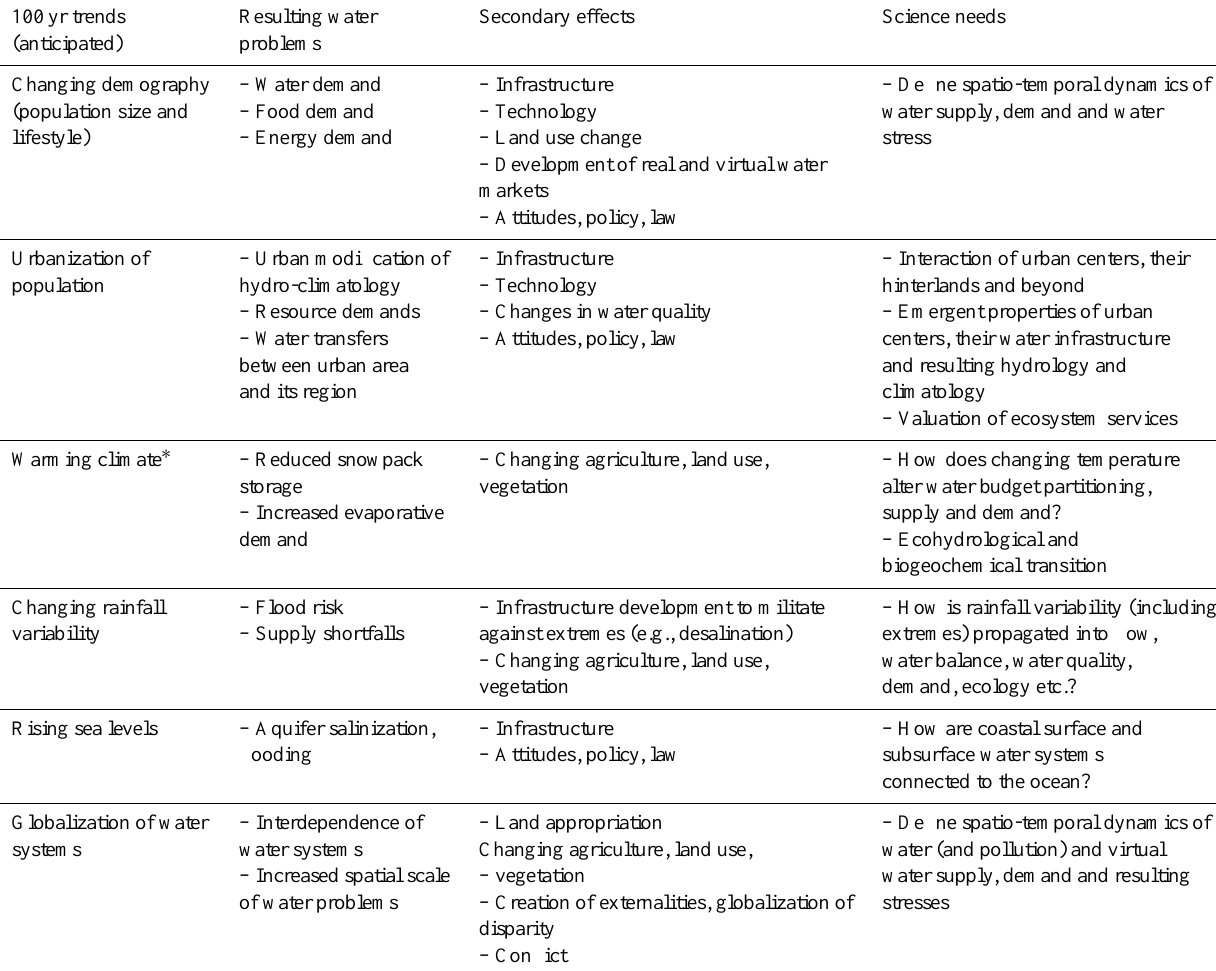
Table 1. Links between some anticipated trends in hydrologic drivers, the water problems that these trends are likely to cause, and the cascade of secondary effects that are generated over a long time frame. Science questions that result from these problems are framed in broad terms, and largely relate to emergent features of water